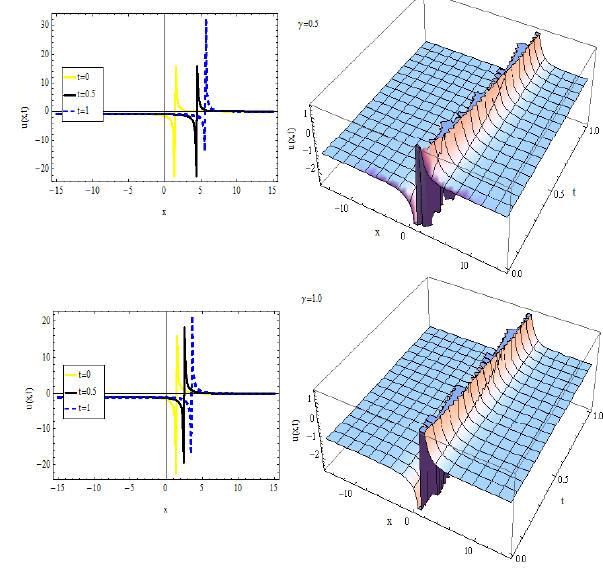
Figure 4: Graph of (32) for conformable time-fractional Cahn-Allen equation.